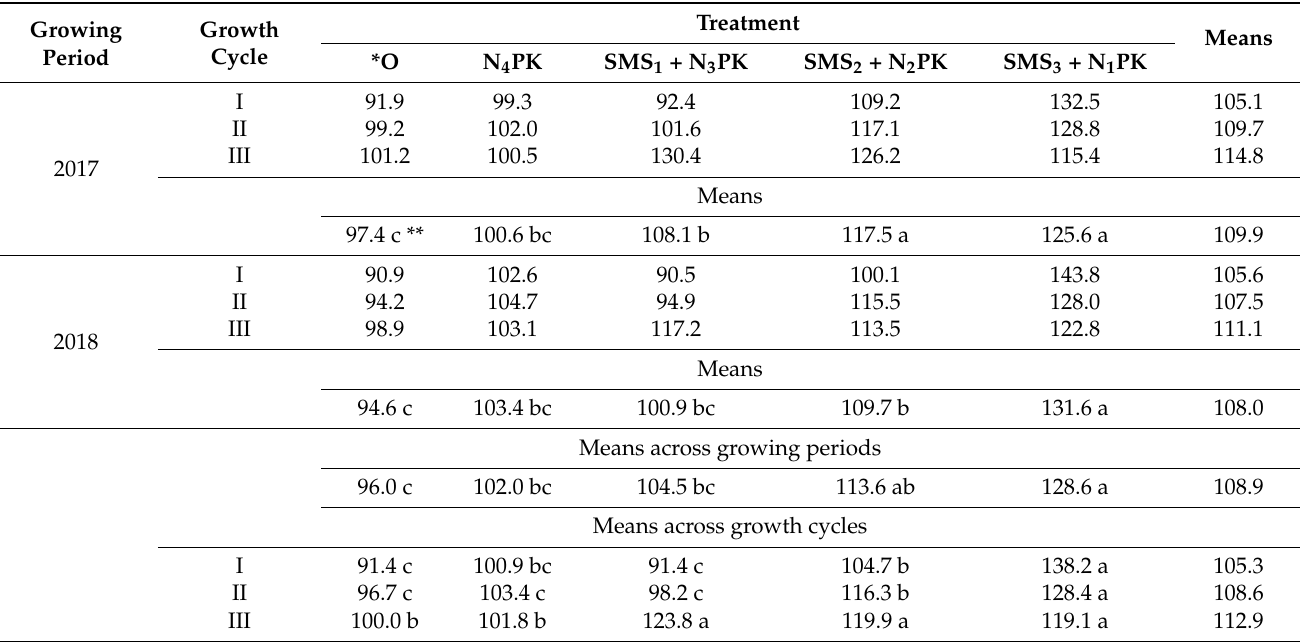
Table 4. The effect of fertilizer treatment, growing period and growth cycle on Festulolium braunii digestible protein content (g · kg − 1